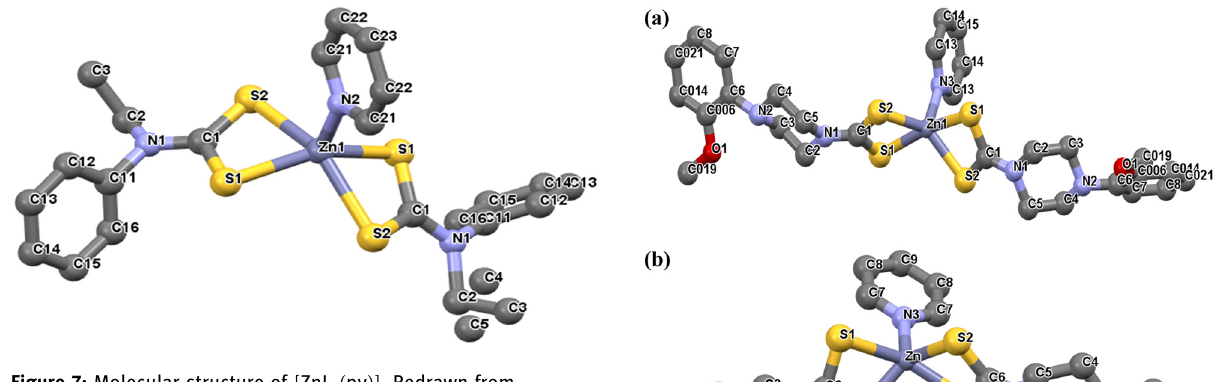
Figure 7: Molecular structure of [ ZnL 2 ( py )] . Redrawn from ref. [ 44 ] , with permission from Royal society of Chemistry ( Copyright 2020 ) .